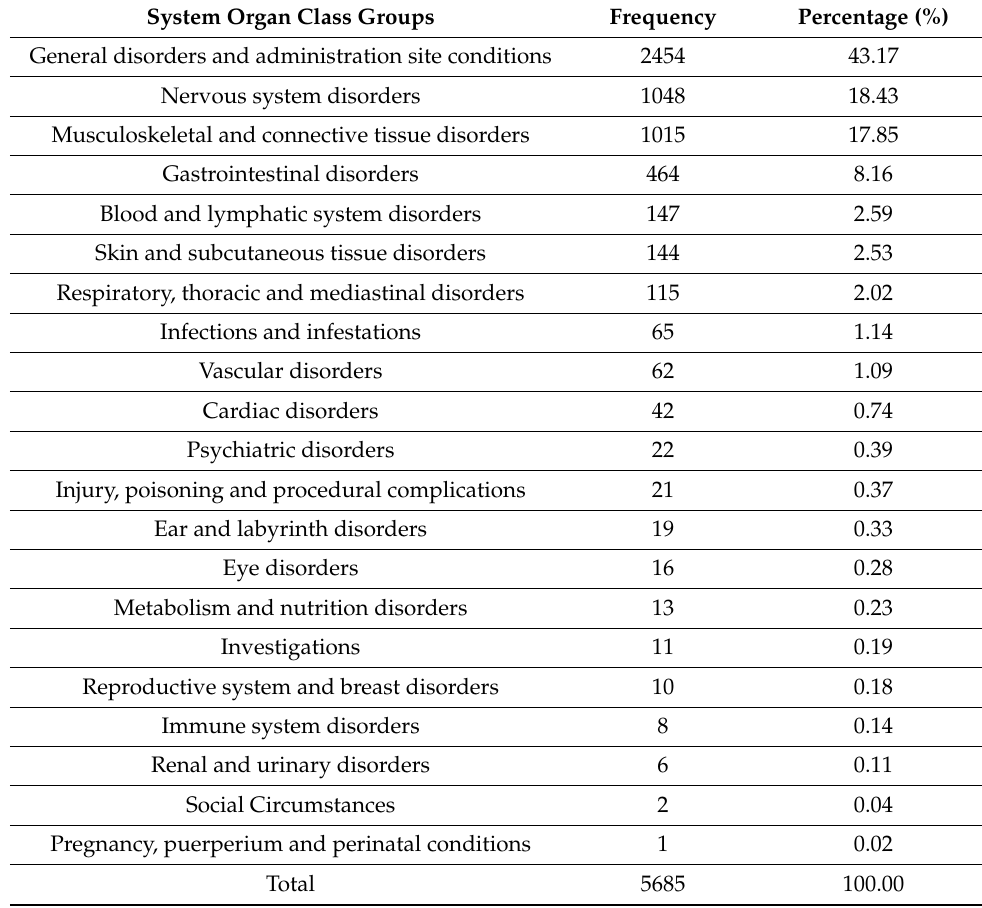
Table 2. Characterization of Adverse Drug Reactions by System Organ Class groups.